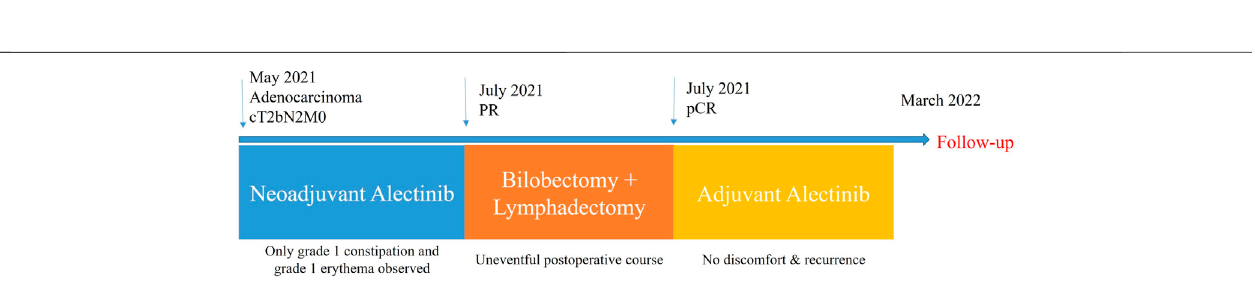
FIGURE 3 | The timeline therapy administration from the episode of care. PR, partial response; pCR, pathological complete response.